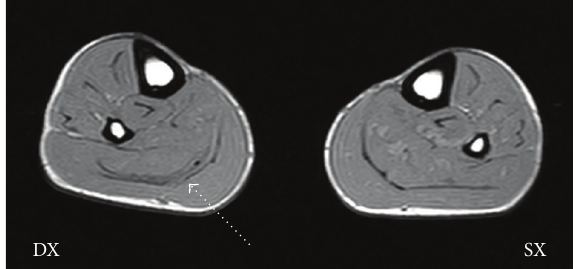
Figure 4: MRI axial section, performed two months after the injury. The arrow shows the thickening scar of the right Crural Fascia. Within the scar tissue, intrascar liquid residue, visible as a black dot, is detectable.